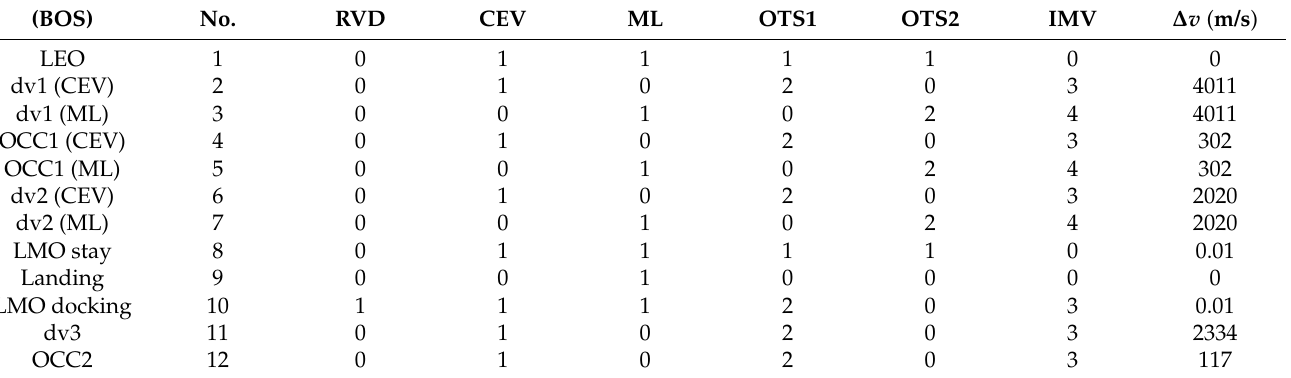
Table 7. Mission architecture matrix of